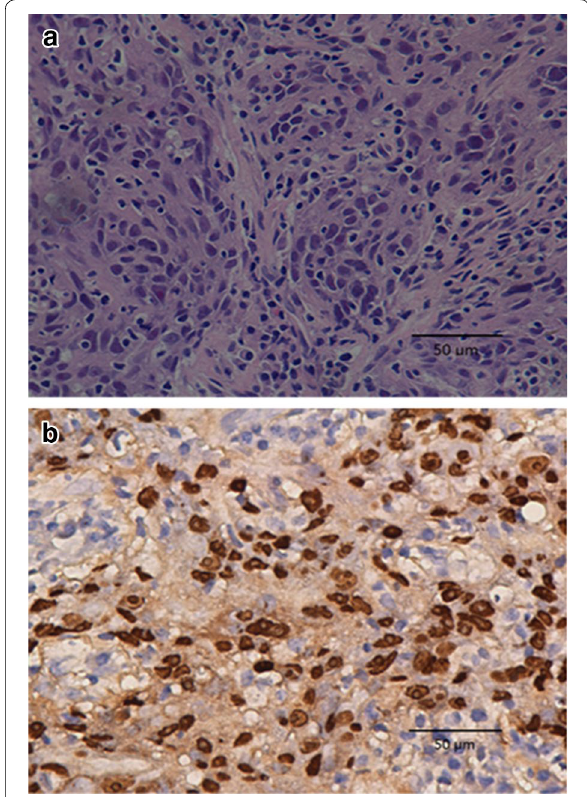
Fig. 1 Representative images of pathologic slices from fine‑needle aspiration of the occipital lymph node (original magnification, a Hematoxylin and eosin (H and E) stained section shows diffused tumor cells displaying characteristics of nasopharyngeal carcinoma (NPC) cells. b Immunohistochemical analysis and in situ hybridization of the occipital lymph node shows the expression of Epstein‑Barr virus‑encoded RNAs (EBERs) in tumor